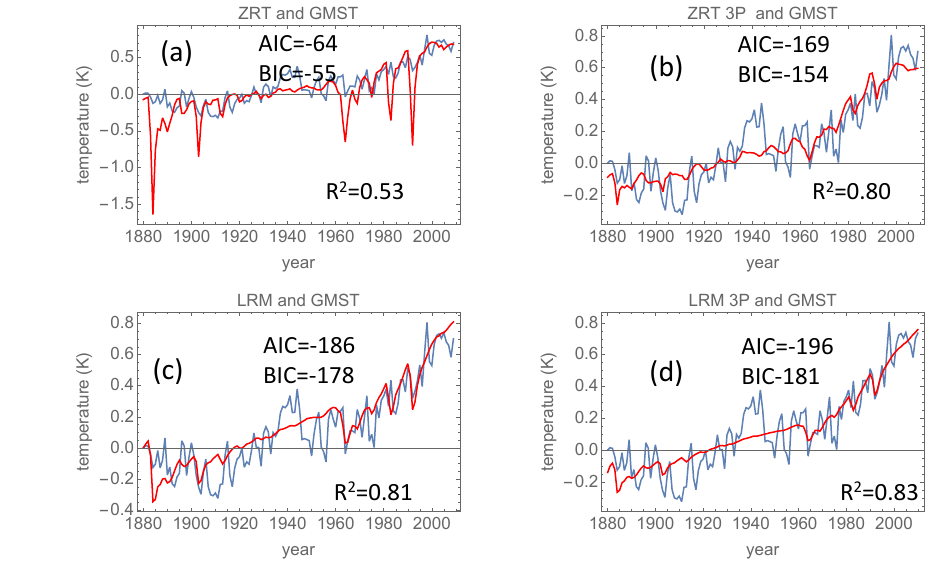
Figure 2. Blue curve in all panels is the instrumental GMST (global mean surface temperature) recorded in the period 1880–2010CE. Panel (a) : the ZRT (zero response time) regressed signal Q ( t ) defined in Eq. (5), with F being the ZRT (identity) filter and F ( t ) the total forcing. Panel (b) : the ZRT 3P regressed signal according to Eq. (1) without AMO and ENSO as predictors. Panel (c) : the LRM (long-range memory) regressed signal Q ( t ) defined in Eq. (5), with F being the LRM filter. Panel (d) : the LRM 3P regressed signal according to Eq. (1) without AMO and ENSO as